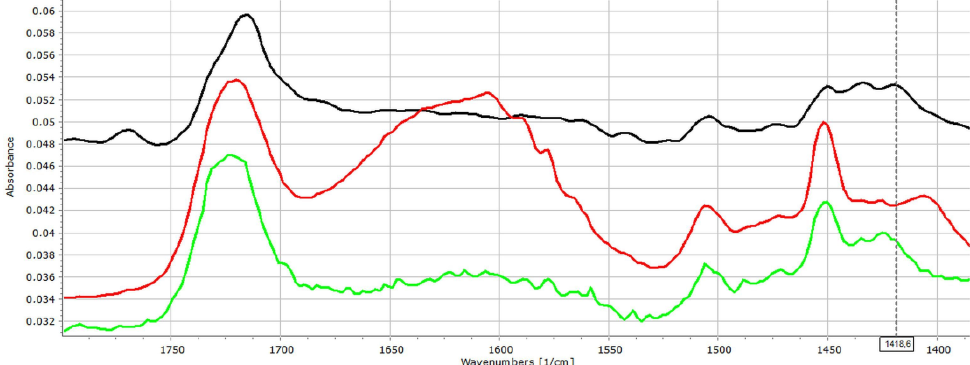
Figure 4. FT-IR spectra of ACE-PVC:EE 75:25 samples: original ( black ), dipped ( red ), and dried ( green ).